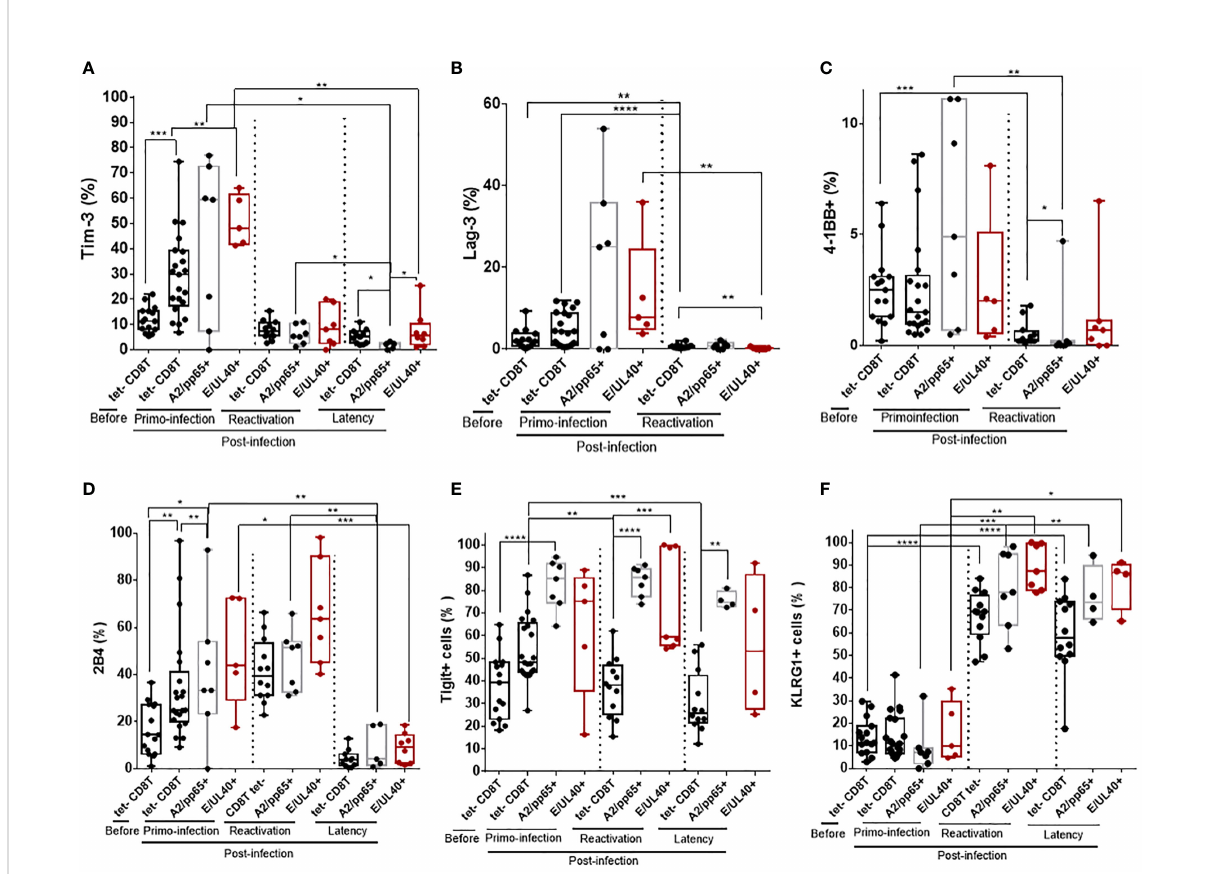
FIGURE 3 Immunophenotype of HLA-E UL40 and HLA-A2 pp65 memory CD8 T cells after a primary HCMV infection, a reactivation in KTR and during chronic infection in HCMV+ HV. After immunostaining and fl uorescence acquisition, CD8Tcell populations were de fi ned using a dedicated gating strategy as reported in the Materials and methods section and in Figure S3 in order to identify pMHC tetramer- CD8Tcells (tet-CD8T), HLA-E UL40 (E/UL40+) and HLA-A2 pp65 (A2/pp65+) CD8Tcells. Box plots with median and interquartile values showing the speci fi c expression for Tim-3 (A) , Lag-3 (B) , 4-1BB (C) , 2B4 (D) , Tigit (E) and KLRG1 (F) . Results are expressed as percents of positive cells in the different CD8 T cell subsets. (A – F) Box plots with median and interquartile values for analyses performed on HLA-E UL40 CD8T cells from KTR with a primary infection (n=5), a reactivation (n=7), from HV with chronic infection/latency (HV; n=9) and on HLA-A2 pp65 CD8T cells from KTR with a primary infection (n=7), a reactivation (n=7), from HV with chronic infection/ latency (n=10) and the respective tet - CD8T cells. Each point corresponds to an individual CD8T response. Statistical analysis was performed by Mann- Whitney U -test. P values: *for p < 0.05, **for p<0.01, ***for p<0.001 and ****for